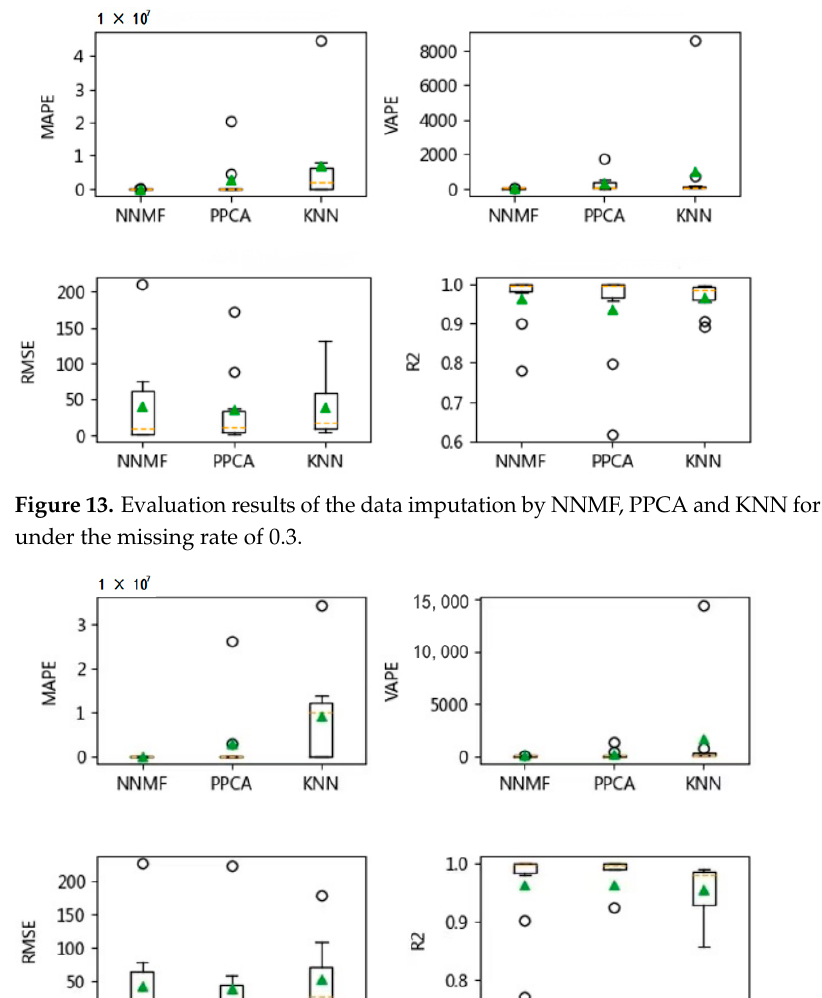
Figure 12. Evaluation results of the data imputation by NNMF, PPCA and KNN for vehicle of ***Y278 under the missing rate of 0.1.